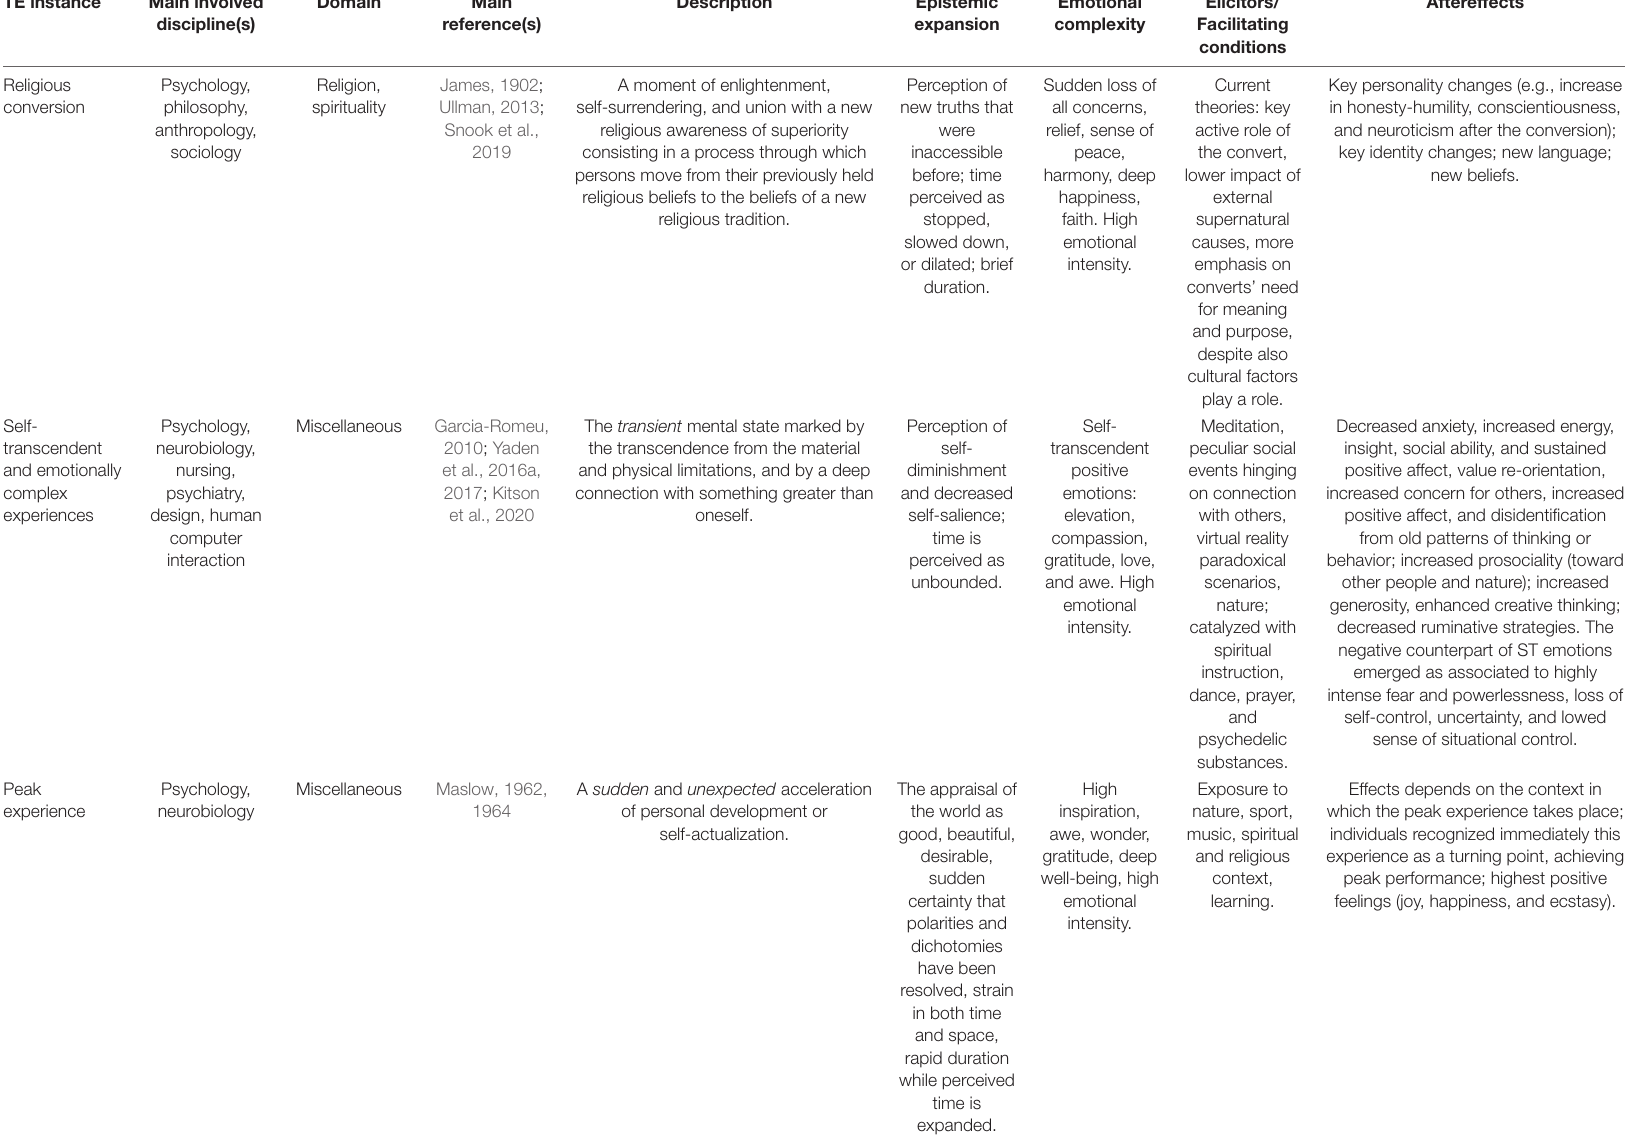
TABLE 1 | Overview TEs instances’ main features: main reference discipline(s), domain(s), phenomenological correlates, elicitors, and